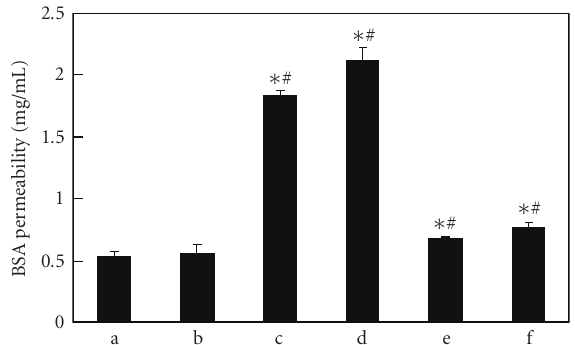
Figure 3: Hypercholesterolemic serum could significantly increase the permeability of endothelial cells, which was detected by albumin permeability test with transwell. And the permeability of endothe- lial cells increased with the concentration of hypercholesterolemic serum. a: serum free medium; b: normal rabbit serum; c: low concentration of hypercholesterolemic serum (0.04mMol/L); d: high concentration of hypercholesterolemic serum (0.32mMol/L); e: c plus 100 nMol/L wortmannin; f: d plus 100 nMol/L. ∗ represents P < . 05 compared with serum-free medium control; # represents P < . 05 compared with previous group.